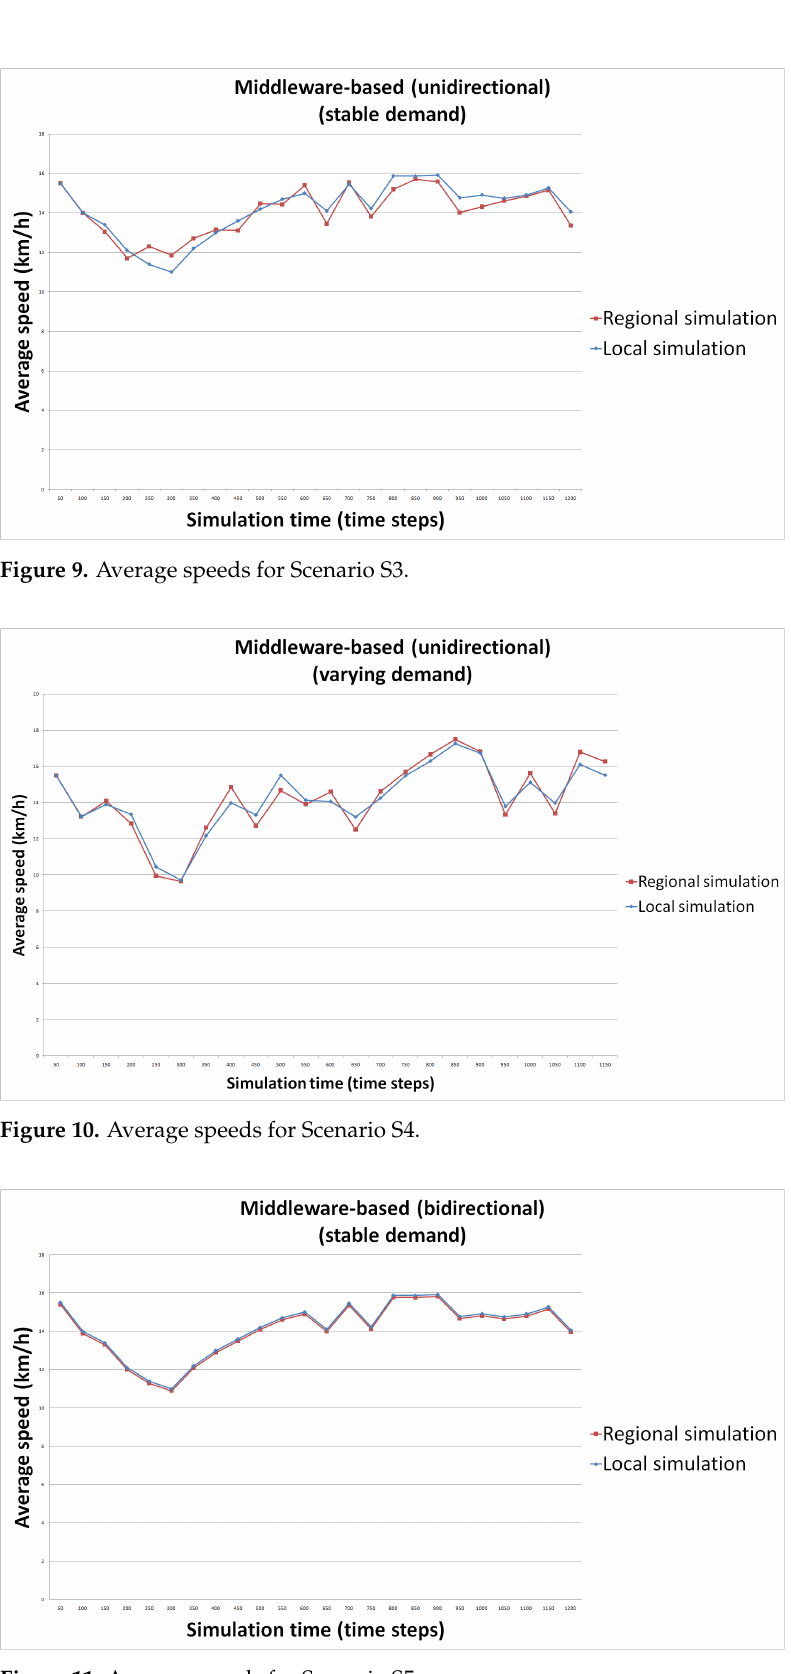
Figure 11. Average speeds for Scenario